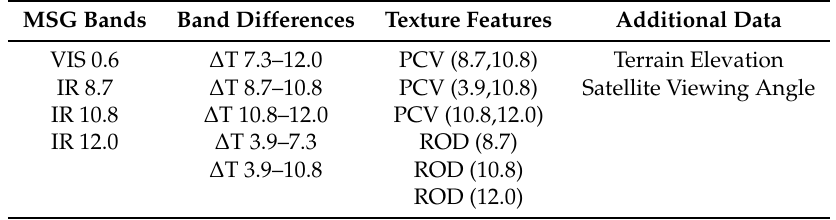
Table 3. Final set of features used for RF training in the second run. MSG bands are denoted with